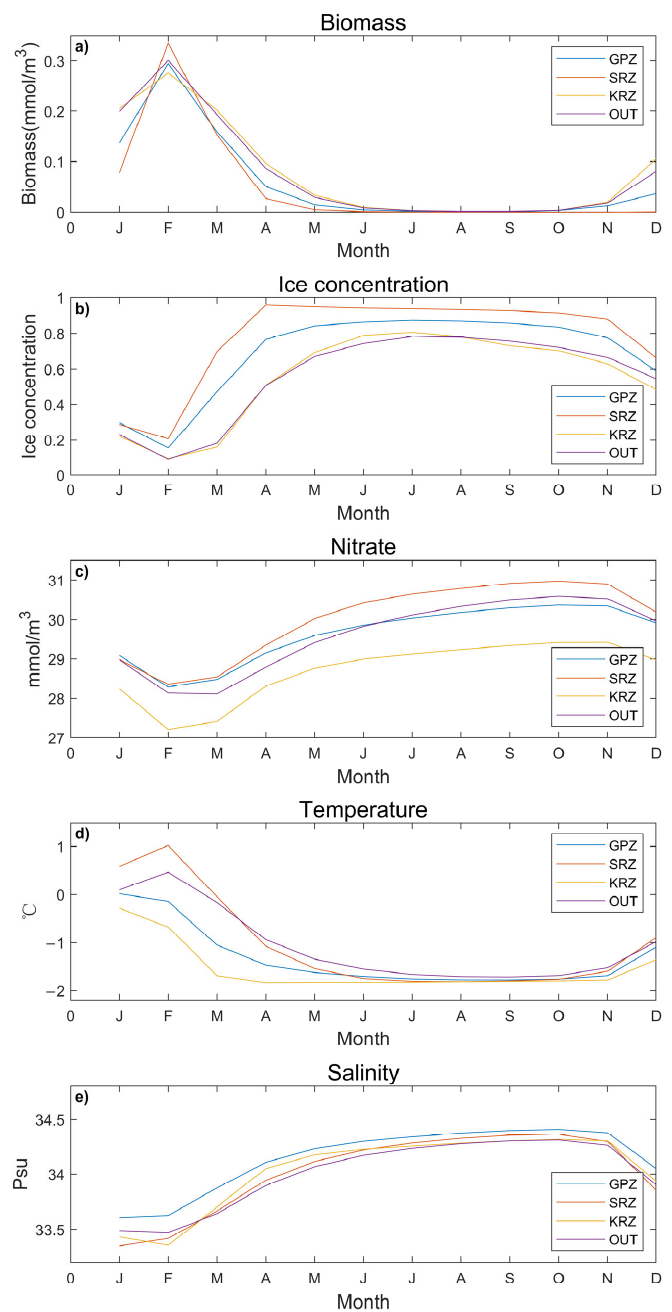
Figure 3. Monthly time-series of the different variables for the four different regions from 1958 to 2018: ( a ) Biomass ( b ) ice concentration; ( c ) nitrate; ( d ) temperature; ( e ) salinity (three type of the MPA region and one outside).